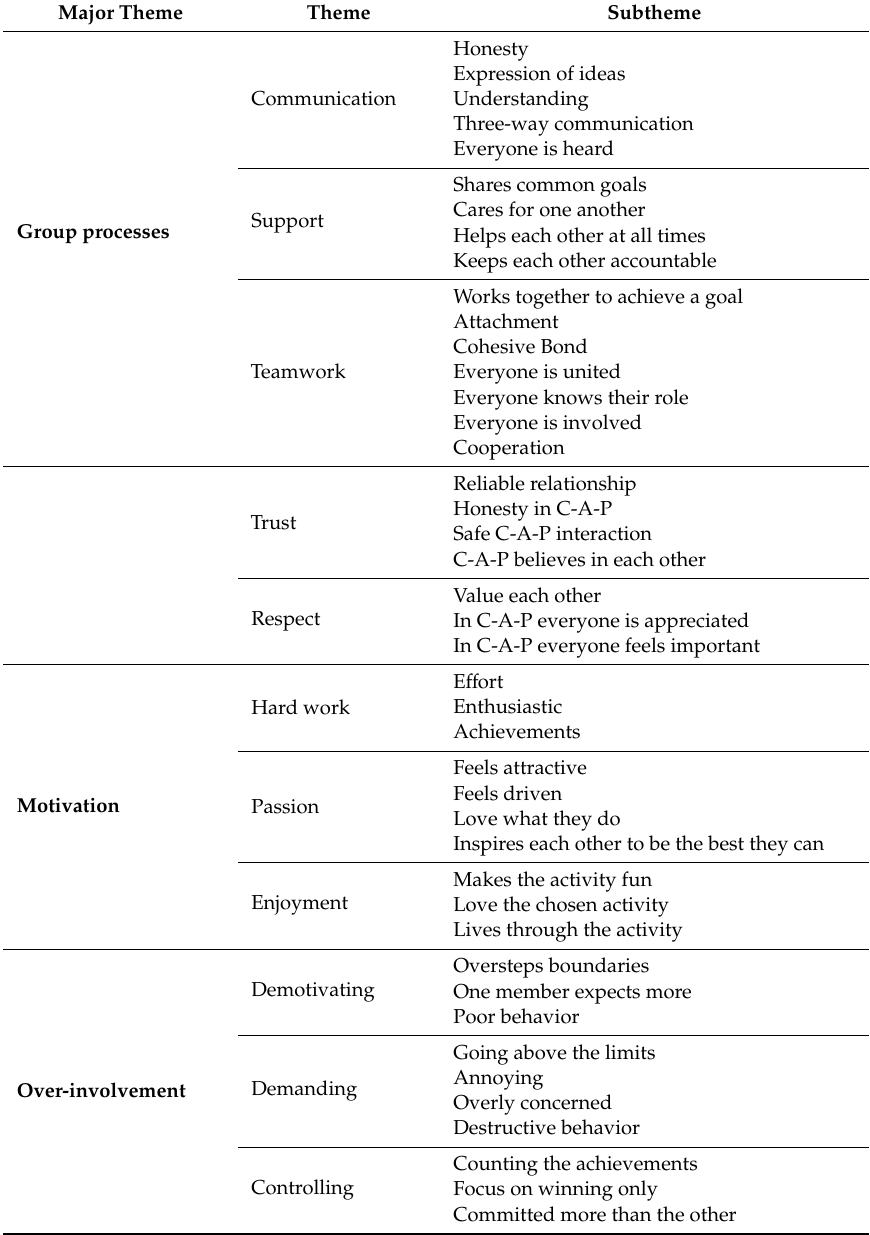
Table 3. The C-A-P phenomenology study theme